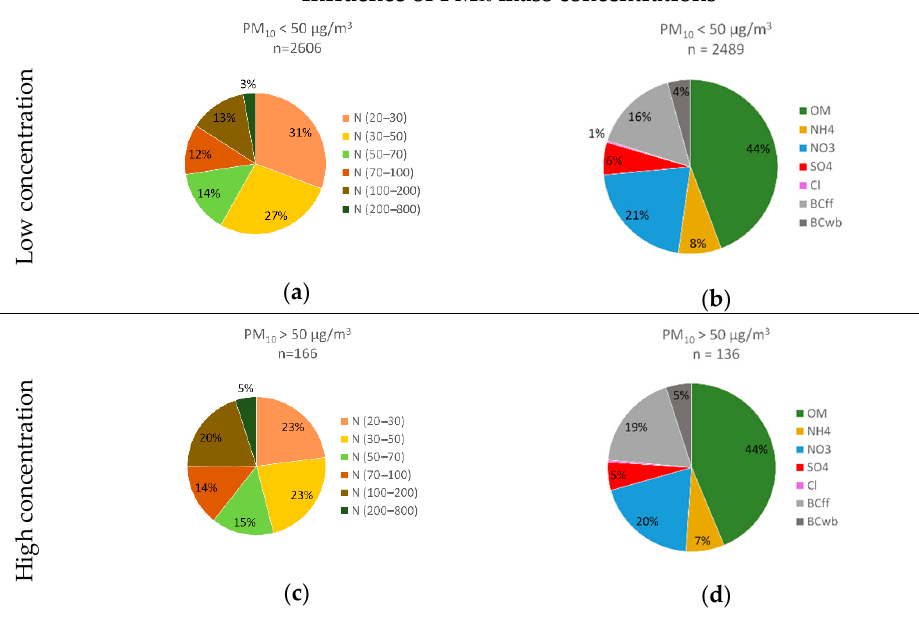
Figure A4. Particle size contribution ( a ) and chemical composition ( b ) for low PM 10 mass concentrations and particle size contribution ( c ) and chemical composition ( d ) for high PM 10 mass concentrations at the roadside site.